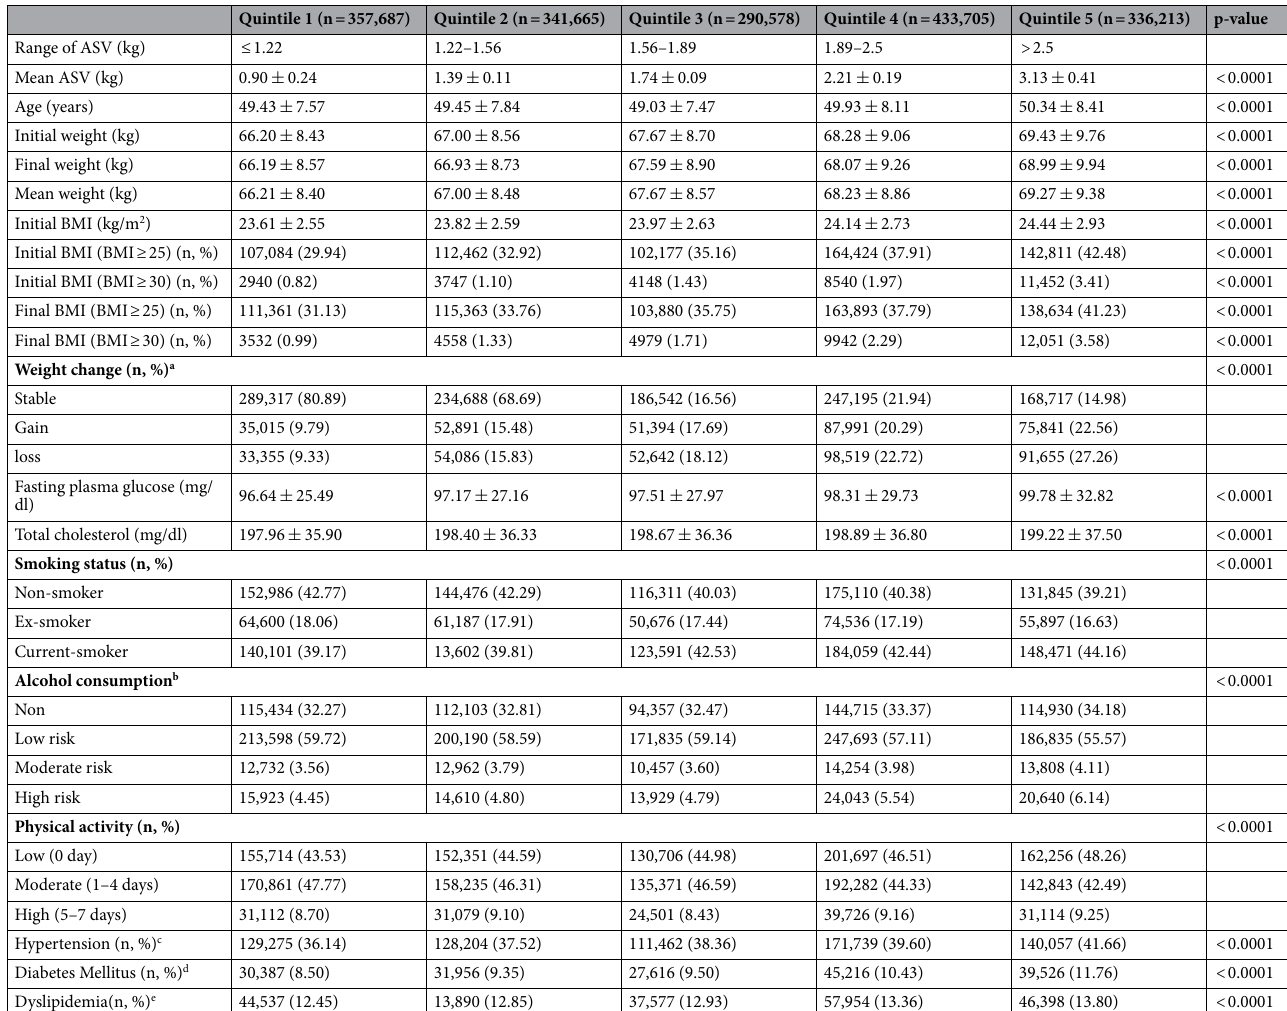
Table 1. Baseline characteristics of the study population according to body weight variability. ASV average successive variability, BMI Body Mass Index. a If the last weight was changed by more than 5% from the initial weight, it was defined as weight gain or loss, whereas we defined the weight as stable if the last weight was changed by less than 5% from the initial weight. b Low, moderate and high risk alcohol consumption was defined as drinking less than 40 g per day, as drinking 40 to 60 g per day, and as drinking more than 60 g per day, respectively. c Hypertension was defined as a systolic or diastolic blood pressure (BP) of ≥ 140/90 mm Hg or the use of antihypertensive medication or history of hypertension. d Diabetes mellitus was defined as a fasting blood glucose ≥ 126 mg/dl or the use of antidiabetic medication or history of diabetes mellitus. e Dyslipidemia was defined as a total cholesterol level ≥ 240 mg/dl or the use of